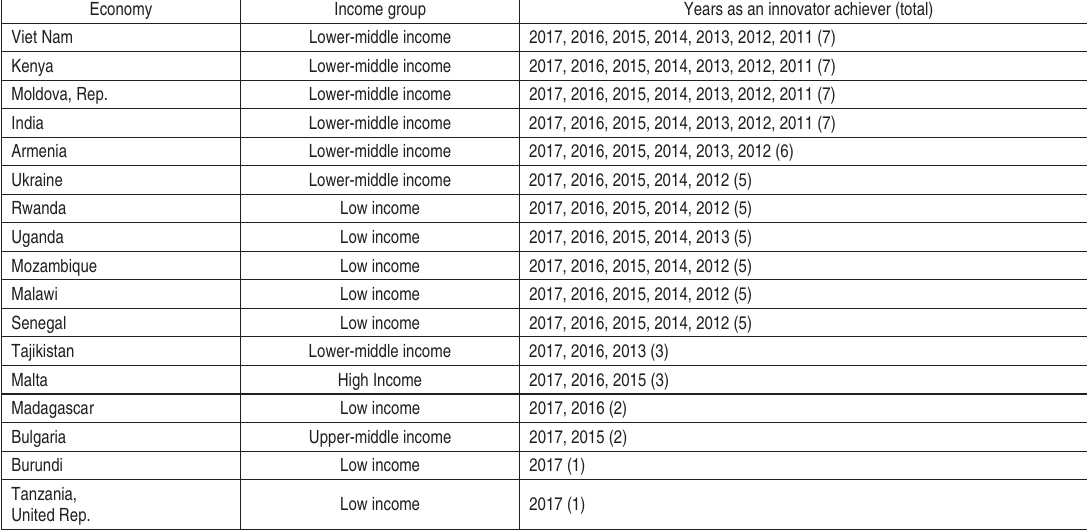
Table 1. Innovation achievers ranking according to GII